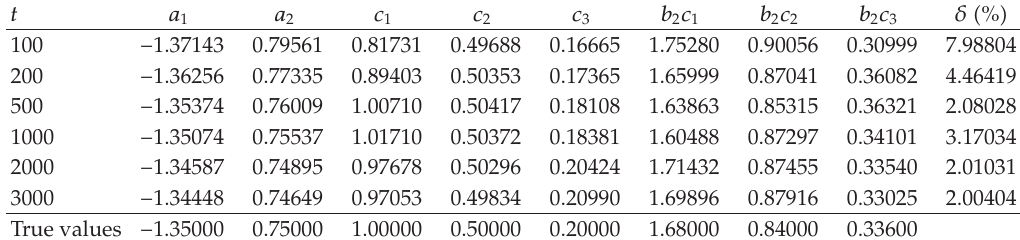
Table 3: The parameter estimates (cid:2) θ (cid:3) (cid:2) σ 2 (cid:7) 1.50 2 , δ ns (cid:7) 32.87% (cid:3) .